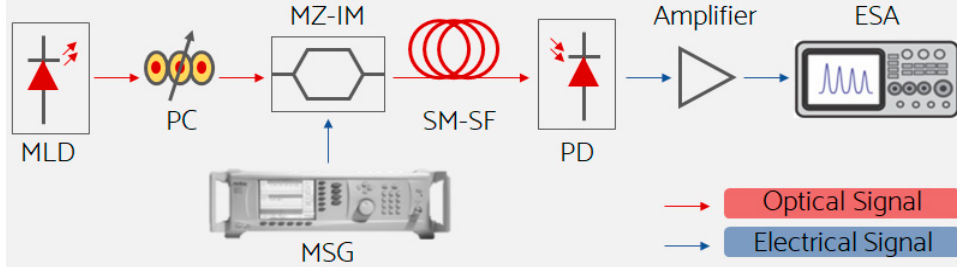
Figure 1. Scheme of the microwave photonic filter.